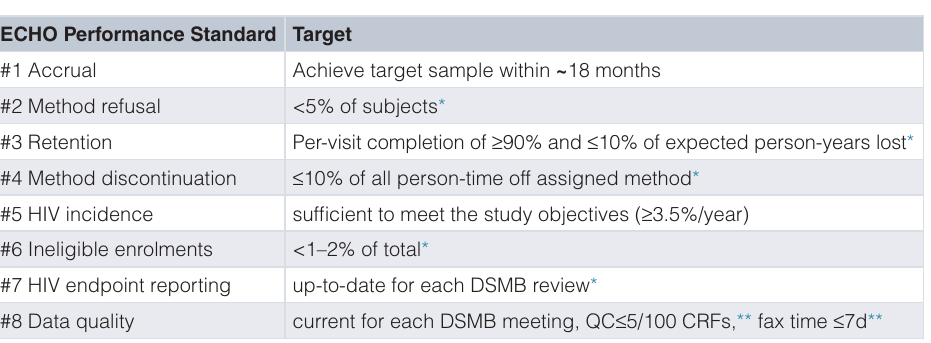
Table 1. ECHO trial operational